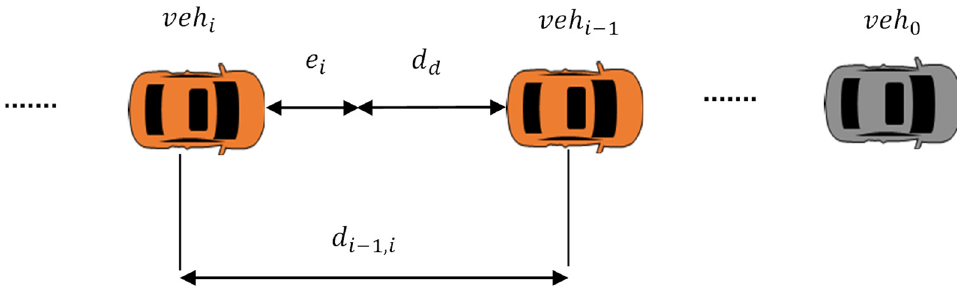
Figure 1. Configuration of a vehicle platoon with a constant distance gap.